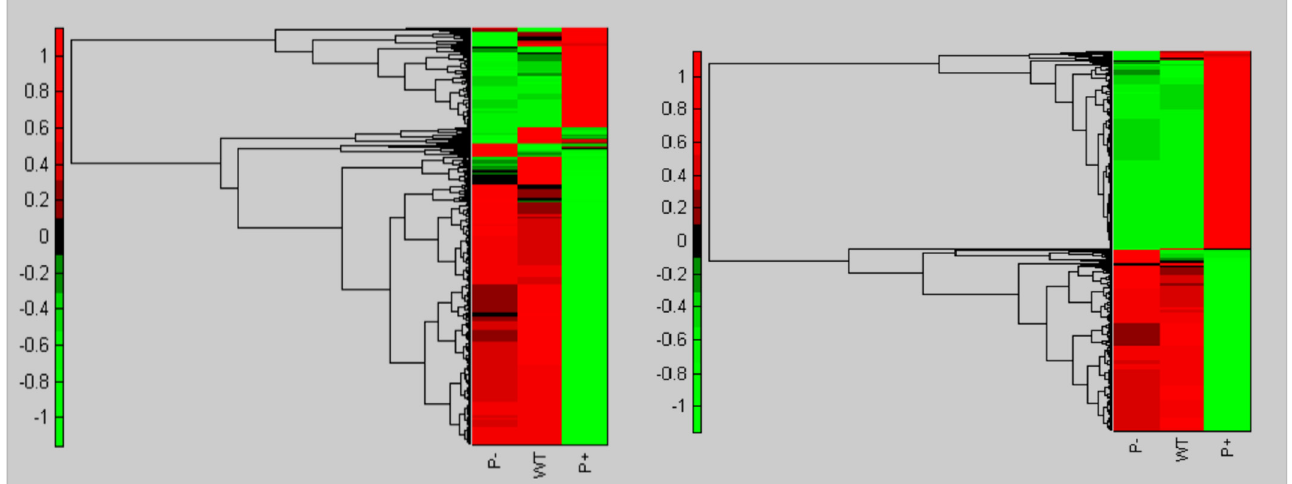
Fig 1. Clustergram of standardized values of all genes (left) and significantly ( P < 0.05) differentially expressed genes (right). Significantly differentially expressed genes are those that are significantly up-regulated (red) /down-regulated (green) in P+ or P – relative to WT.